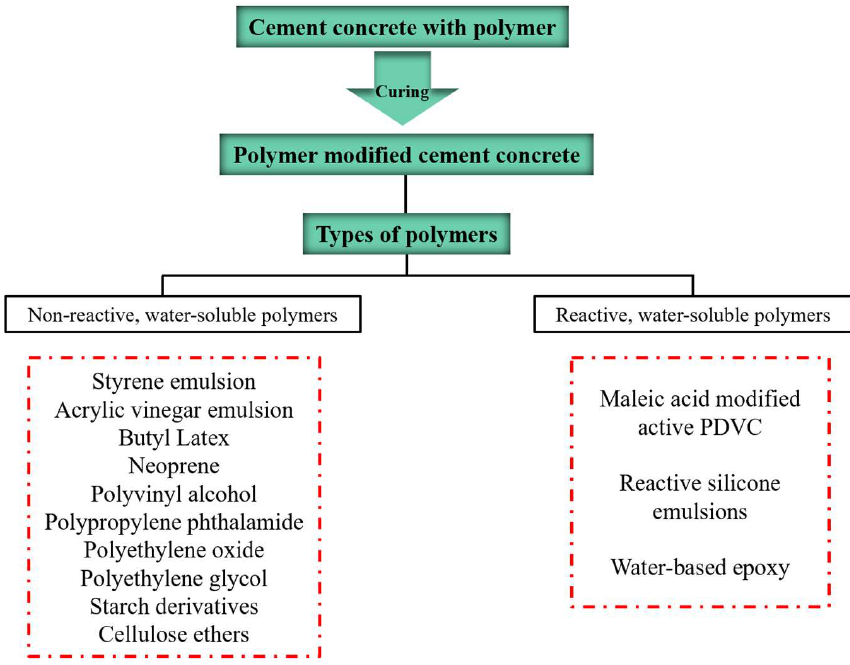
Figure 2. Classification of polymers used in polymer-modified cement concrete.